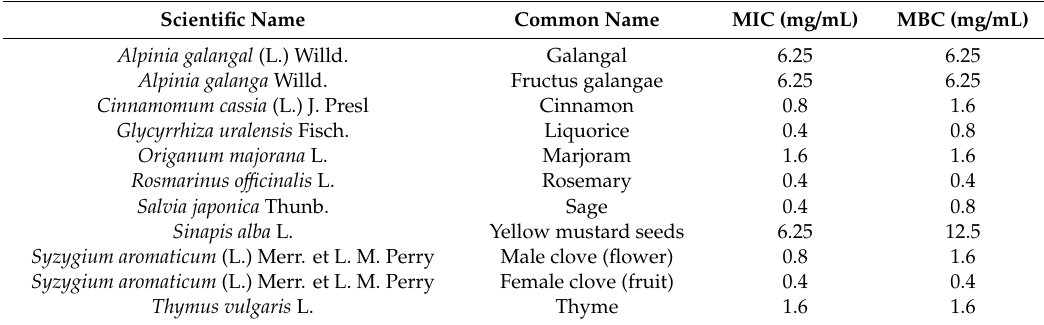
Table 3. Minimum inhibitory concentration (MIC) and minimum bactericide concentration (MBC) values of selected 11 spice extracts with good antibacterial